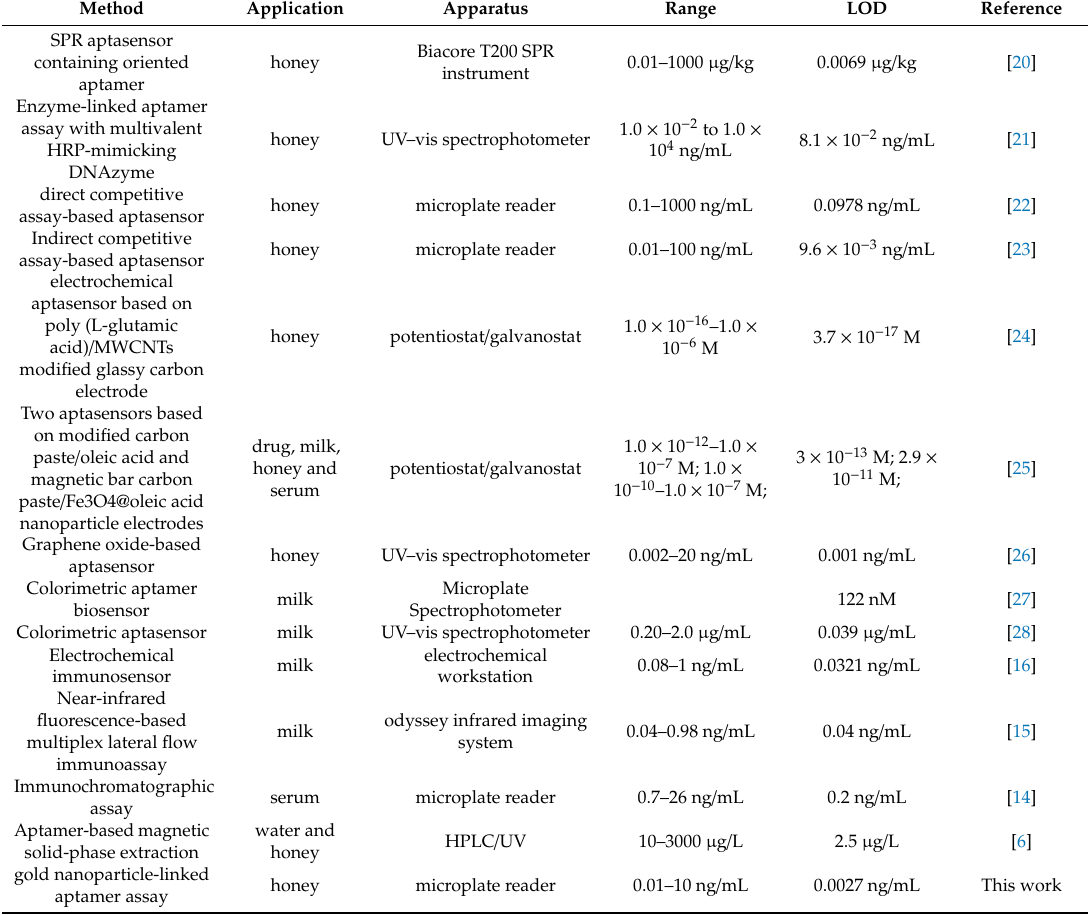
Table 3. Comparison of the analytical methods for tetracycline